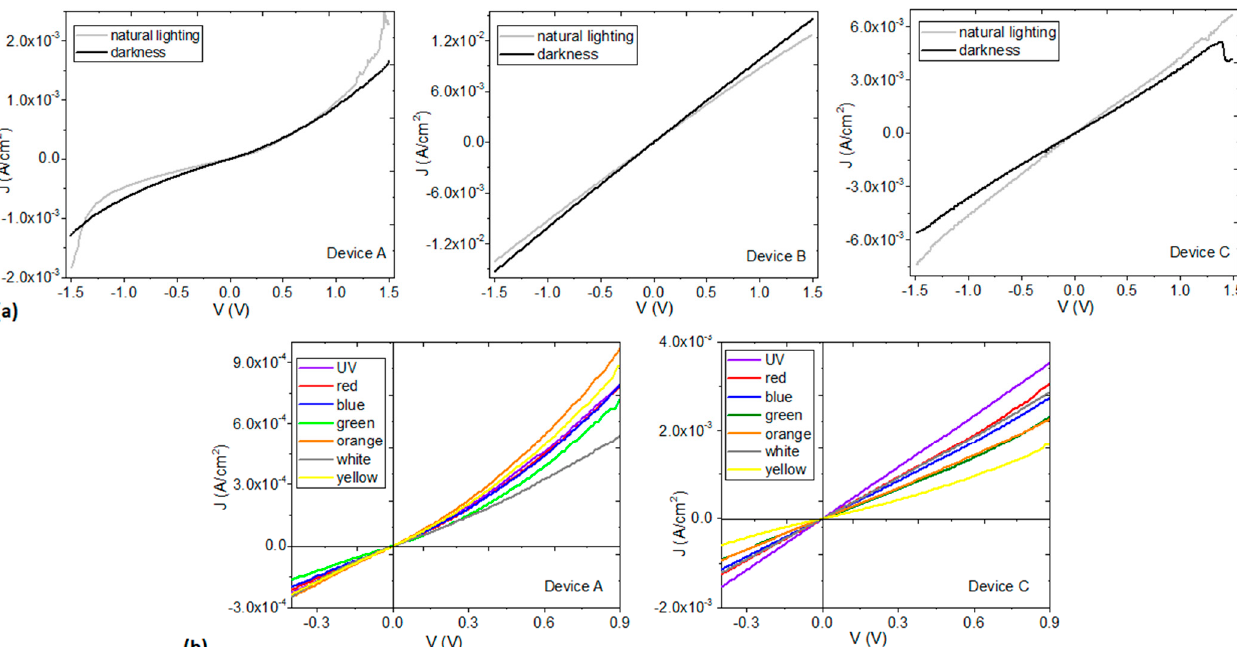
Figure 6. J-V curves from ITO/MoO 3 /PEDOT:PSS-organotin (IV) complex/Ag devices under ( a ) natural lighting/darkness conditions and ( b ) different lighting conditions.